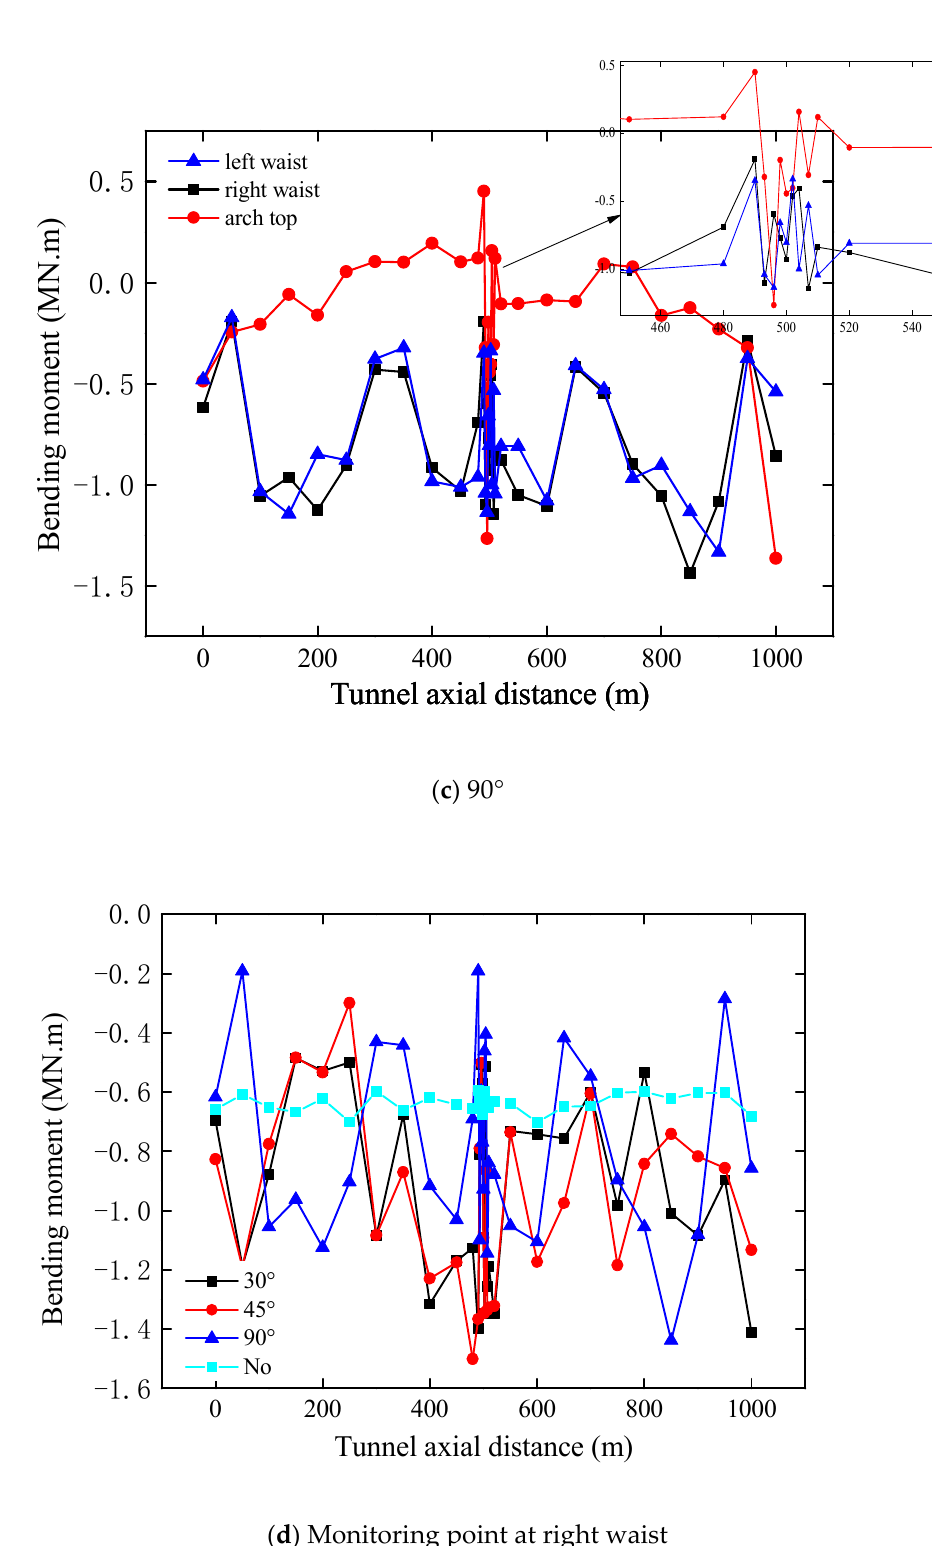
Figure 6. Bending moment of the lining monitoring points of the tunnel passing through adverse geological structure zone with different inclinations along the tunnel axial direction.